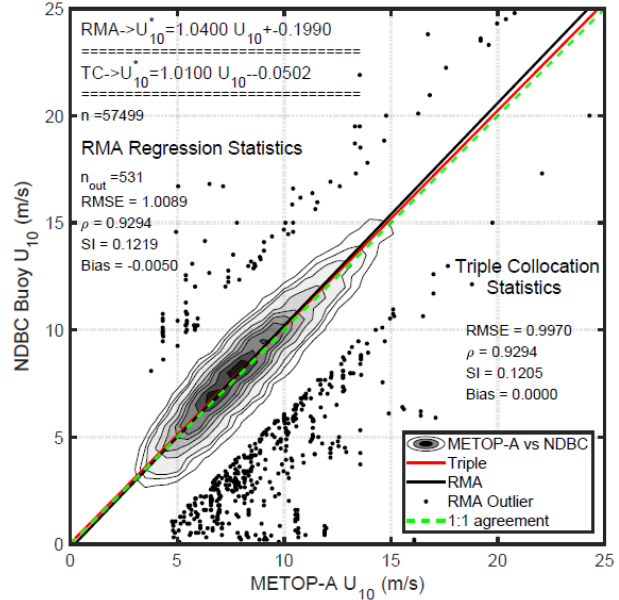
Figure 4. Calibration of METOP-A wind speed against National Data Buoy Center (NDBC) buoy data using reduced major axis (RMA) and triple collocation. The contours represent the normalized density of data points, with contours drawn at 0.9, 0.7, 0.5, …, 0.1, 0.07, 0.04 (maximum value is one). Dots represent outliers excluded from RMA regression using robust regression. 𝑈 10∗ refer to calibrated values of wind speed and 𝑈 10 to uncalibrated values. n and n out are the number of clean (i.e., not outliers) collocated measurements and the number of outliers, respectively.